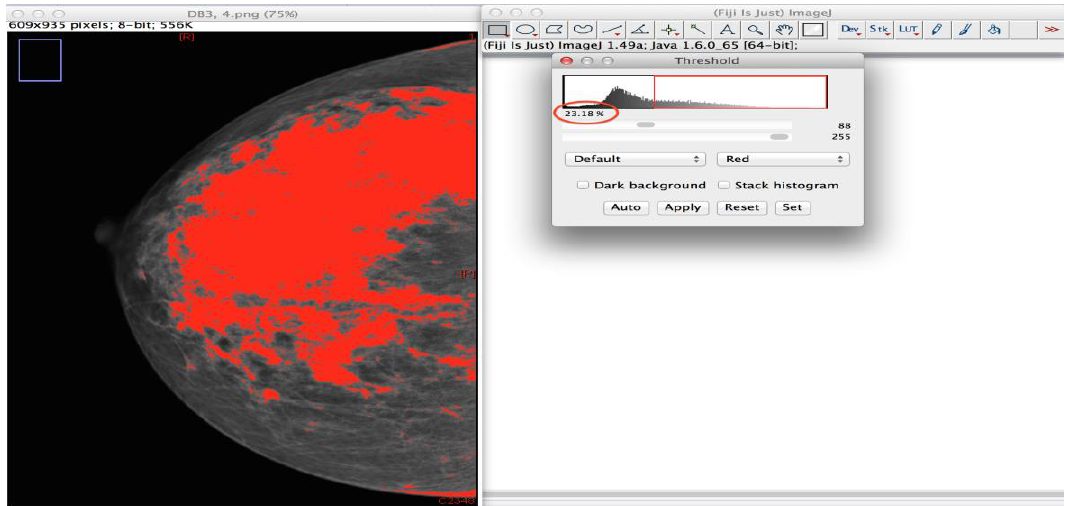
Figure 2. Screenshot of the semi-objective (ImageJ) software, showing a right Cranio-Caudal image with the density as highlighted and the red circle represents the volume density percentage by the software.